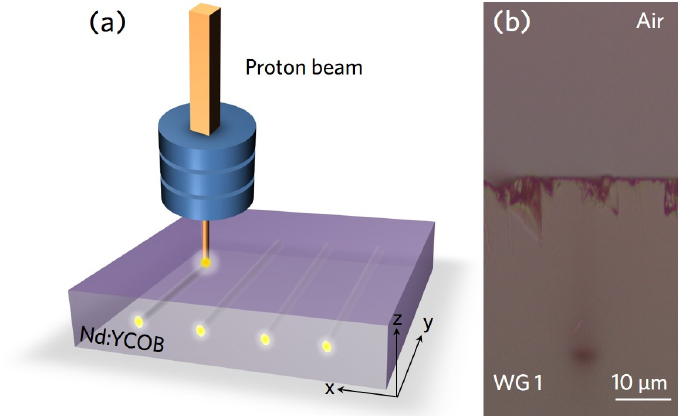
Figure 1. ( a ) Schematic illustration of PBW fabrication of Nd:YCOB channel waveguides. ( b ) Micro- scopic image of waveguide cross-section.